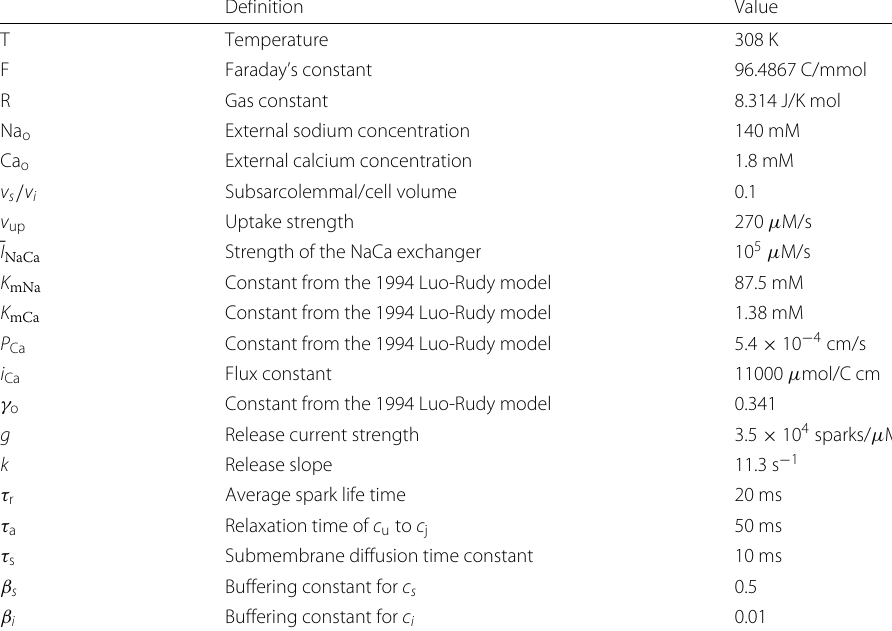
Table 1 Standard parameter values used in the study